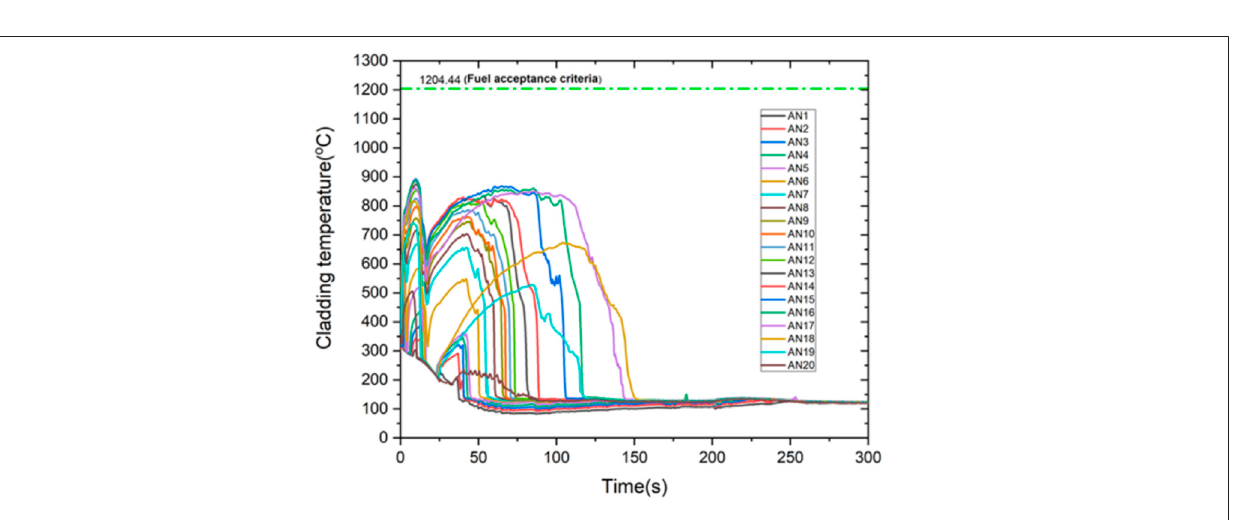
FIGURE 2 | Cladding axial temperature for the hot